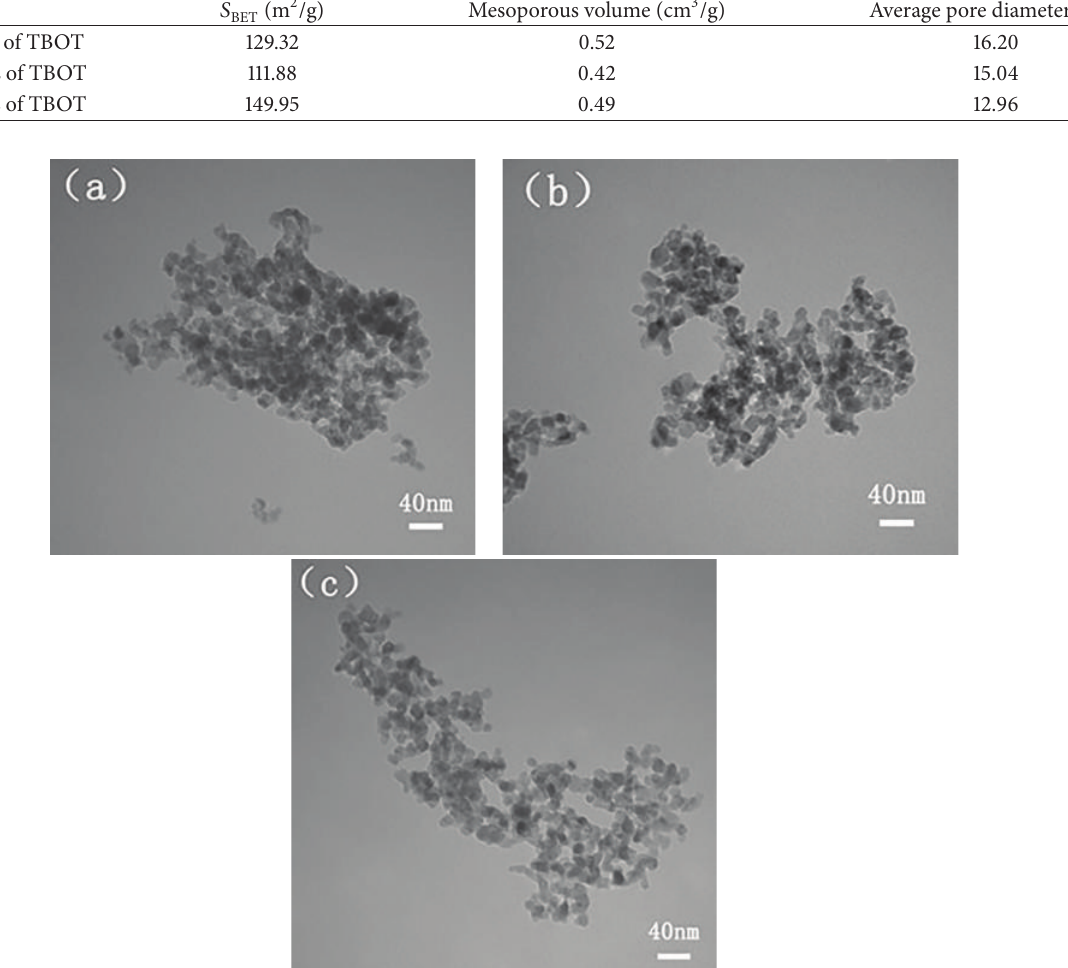
Figure 3: TEM images of TiO 2 aerogel: (a) aspherical TiO 2 aerogel-0.1 mL of TBOT, (b) aspherical TiO 2 aerogel-0.5 mL of TBOT, and (c) spherical TiO 2 aerogel-5.0 mL of